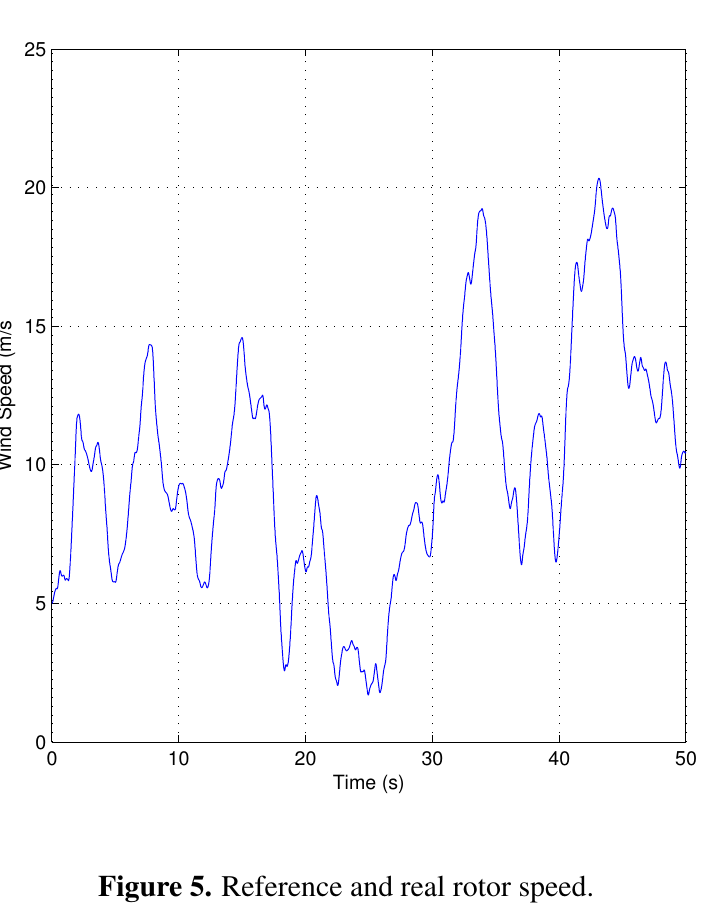
Figure 4. Wind speed.